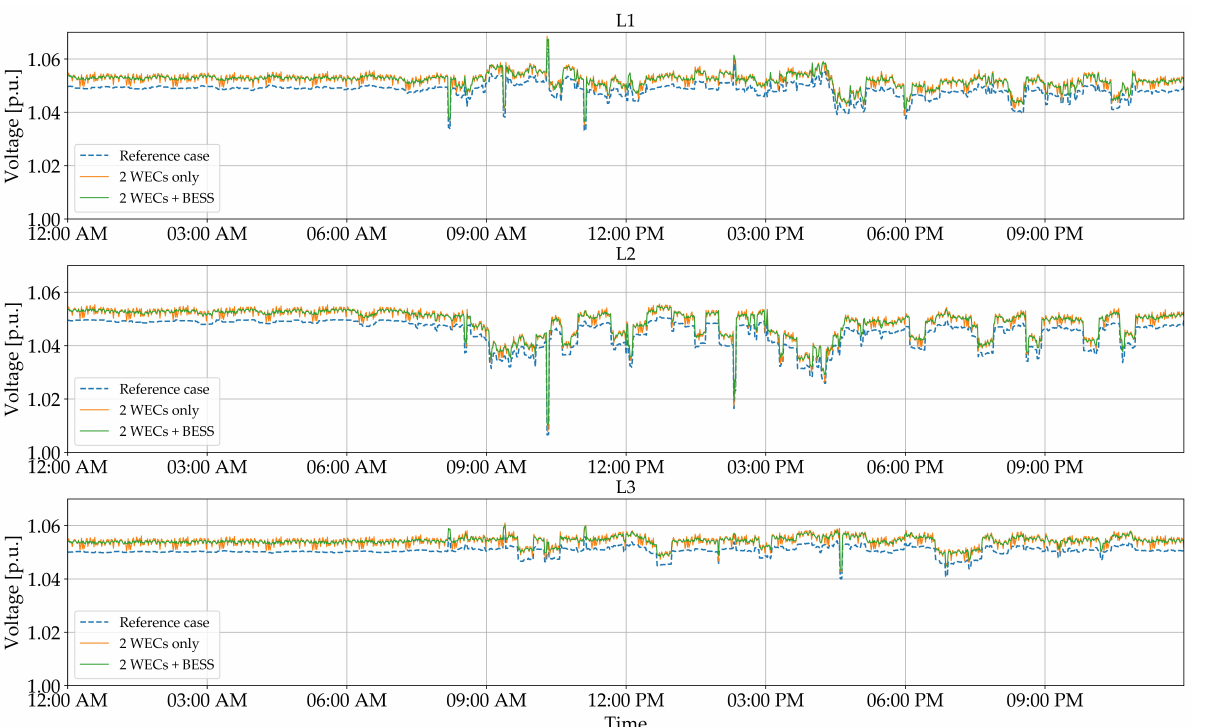
Figure 14. Active power exchange of the LVTF and upstream network at the swing bus for various scenarios in case study 1. Figure 15 gives the voltage profiles of each phase (L1, L2 and L3) at the WPF (and BESS) PCC bus (bus 881) for the following scenarios in case study 1: reference case (load only, no WPF, no BESS); WPF with WECs only (2 WECs only); the combination of WPF with two WECs and BESS (2 WECs + BESS).